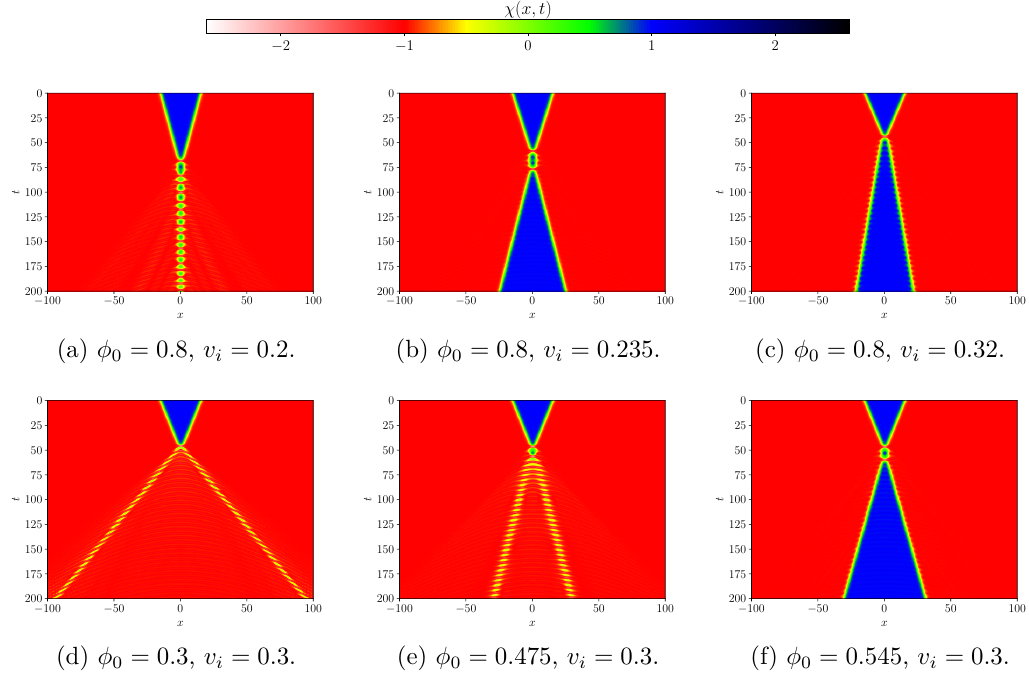
Figure 4 . Scalar field evolution in spacetime. We consider the attractive case where the fermions start at the zero